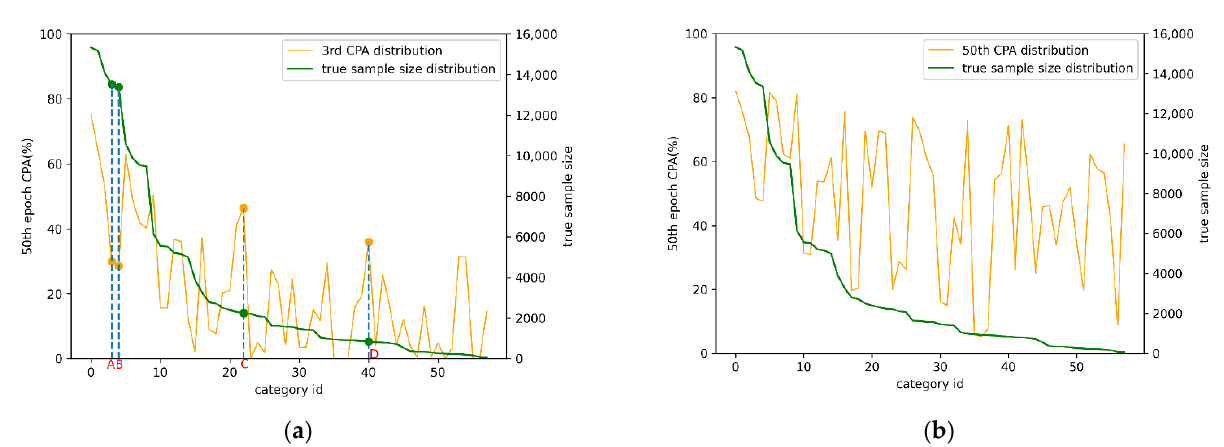
Figure 3. Comparison of Class Pixel Accuracy (CPA) distribution of different epochs and real data distribution in MHPv2.0 dataset. ( a ) The green curve represents the sample size distribution in MHPv2.0 dataset, and the yellow curve represents the CPA of each category. ( b ) We cannot find the correlation between the CPA distribution of 50th epoch and the correct rate distribution.